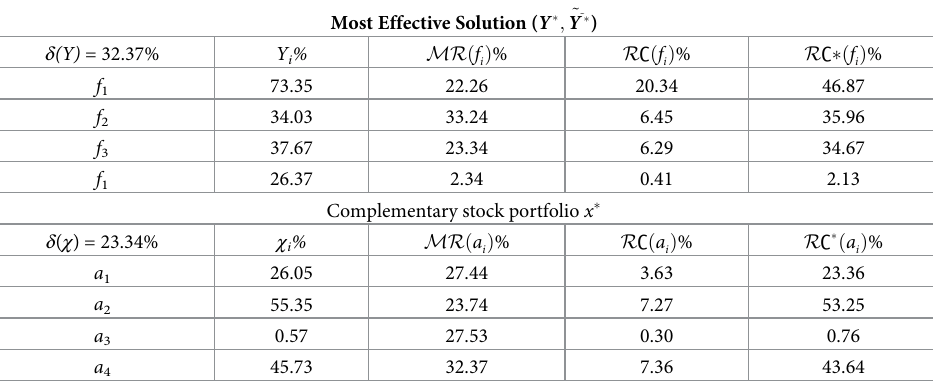
Table 3. Creating a match between the risk budgets (21%, 39%,